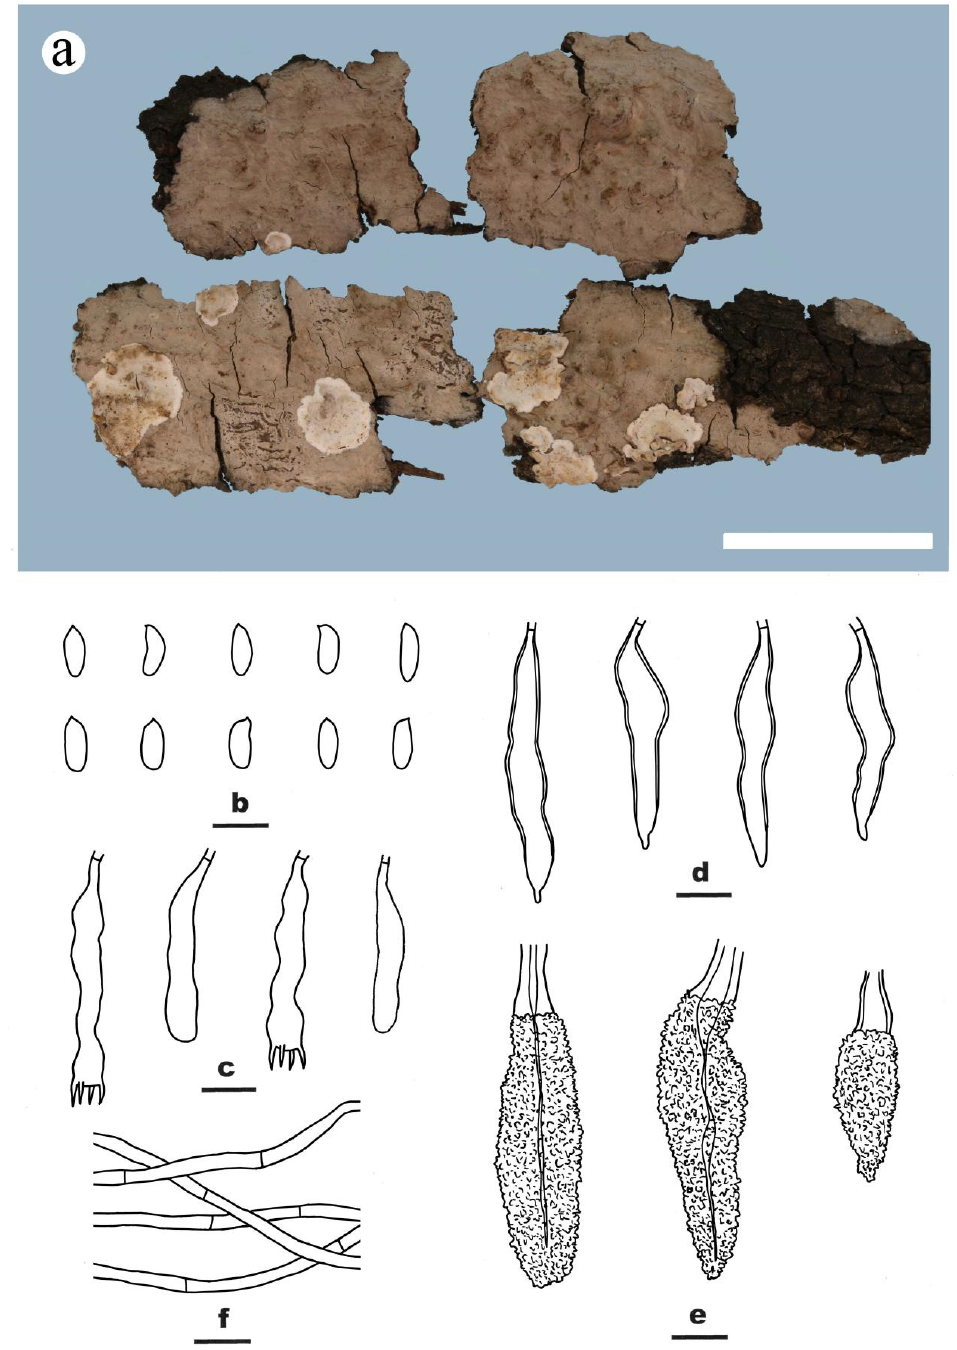
Figure 5. Peniophora shenghuae (from the holotype BJFC 021904). Scale bars: ( a ) = 1 cm; ( b – f ) = 10 µ m. ( a ). Basidiomes; ( b ). Basidiospores; ( c ). Basidia and a basidiole; ( d ). Gloeocystidia; ( e ). Lamprocys- tidia; ( f ). Hyphae from subiculum.